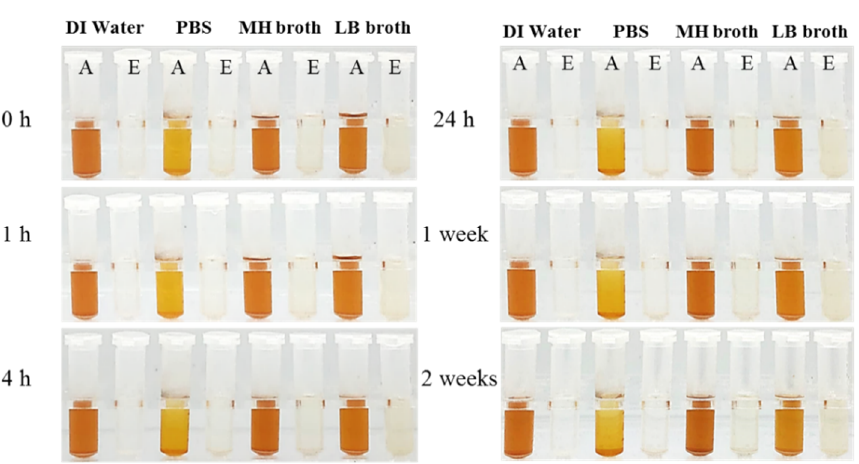
Figure 6. Images of (A) A-BG-AgNPs and (E) E-BG-AgNPs (50 µg/mL) in different media after in-